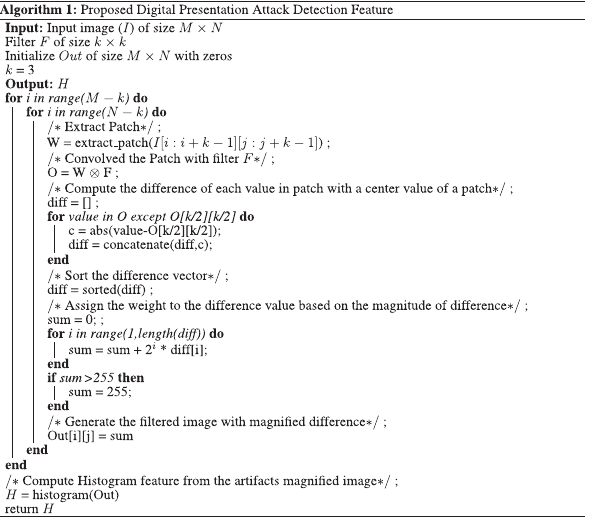
Frontiers in Arti fi cial Intelligence |